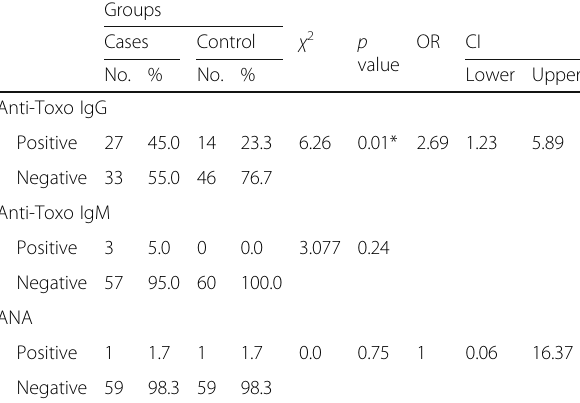
Table 4 Relation between anti-Toxoplasma IgG prevalence and clinical findings among patients (group